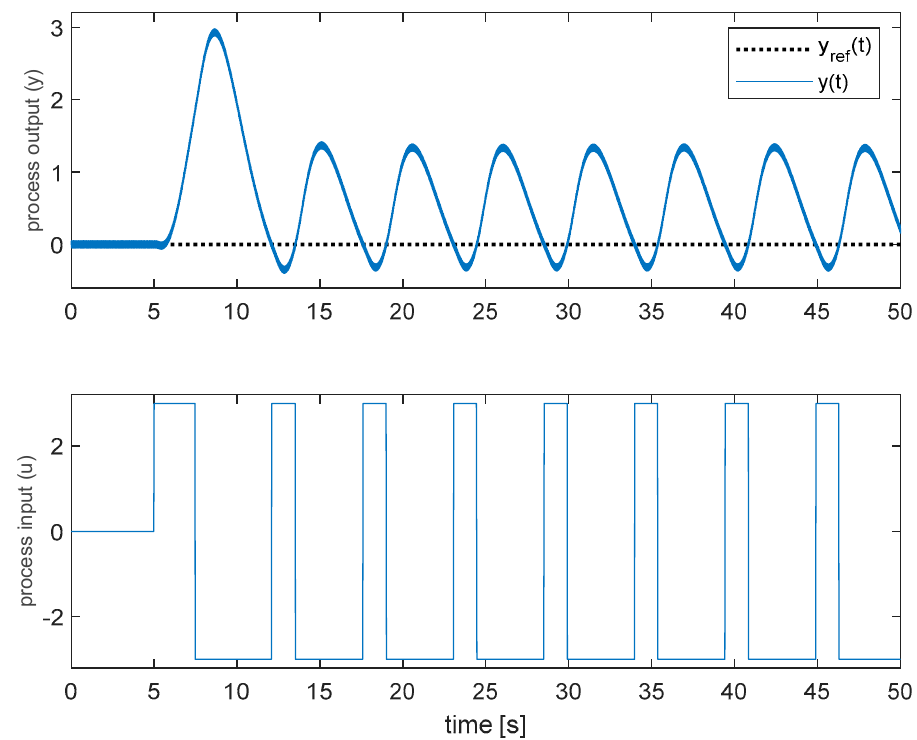
Figure 14. Response of the relay feedback method [1] for the non-minimum phase process with θ = 0.1 and PA set = − π .